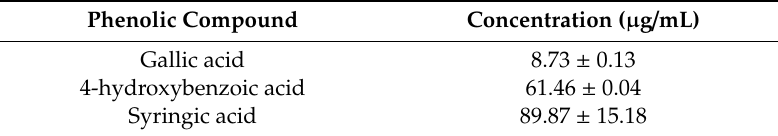
Table 2. Selected phenolic compounds determined in the DDP